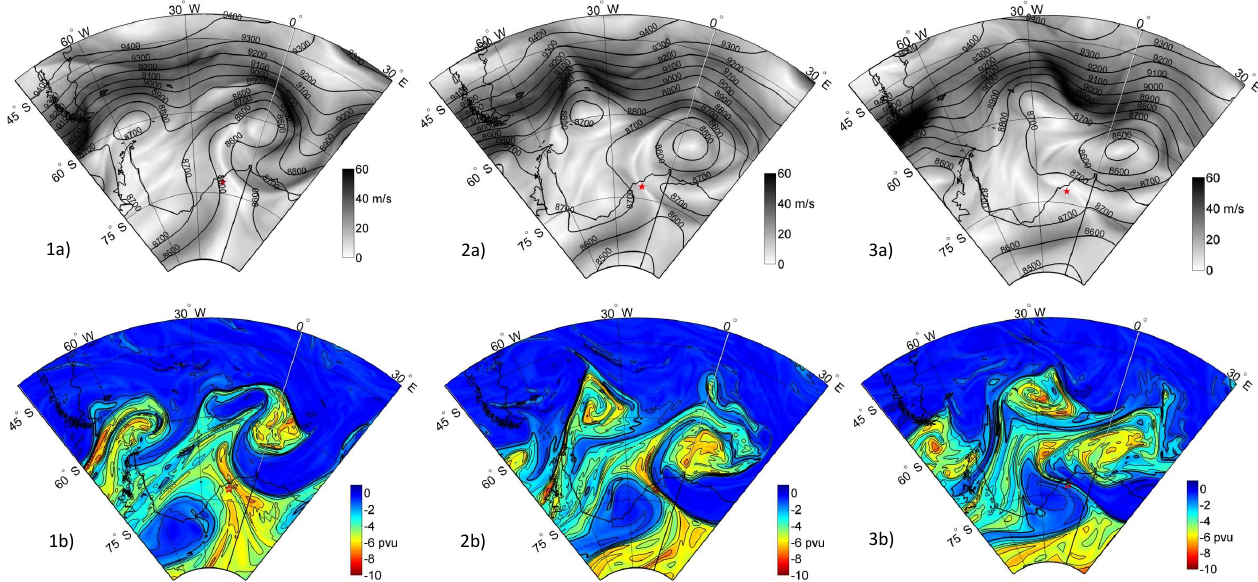
Fig. 3. ECMWF operational analysis based geopotential height (gpm) and wind speed (ms − 1 ) at 300hPa level (1a, 2a, 3a) and potential vorticity (pvu) (thick line − 2pvu value) at 315K isentropic level (1b, 2b, 3b) on 28 December 2010 06:00UTC (1a, 1b), 29 December 2010, 00:00UTC (2a, 2b) and 29 December, 12:00UTC (3a, 3b). Map grid used as seen in Fig. 2a. Red star marks position of MARA